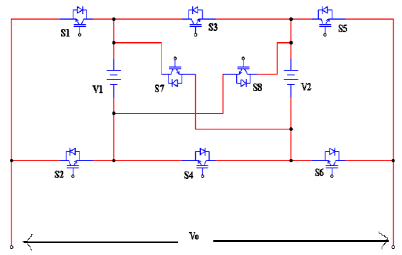
Figure 30. Bidirectional switch MLI circuit.